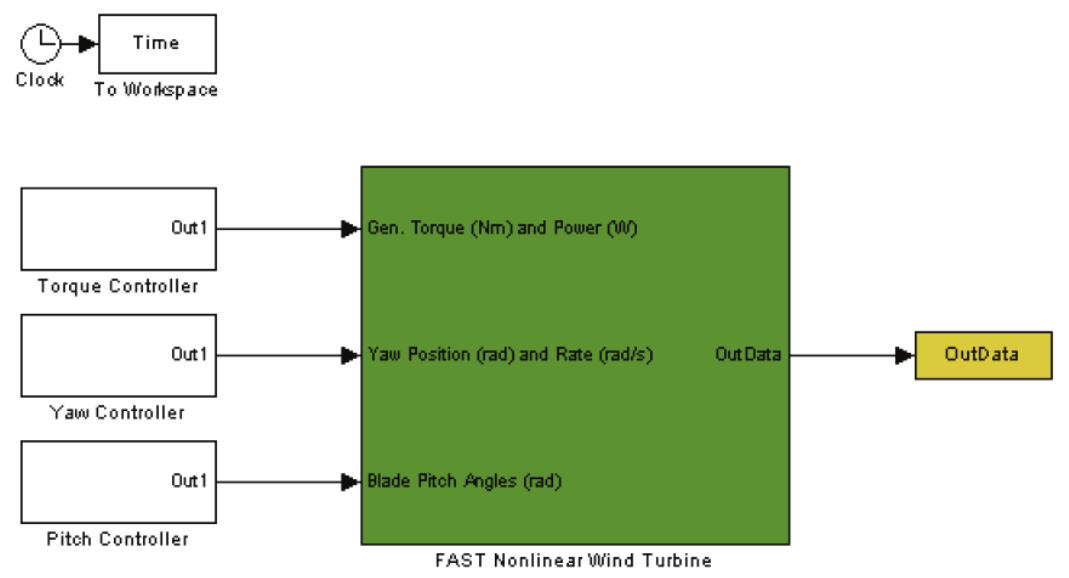
Figure 2. Simulink open-loop